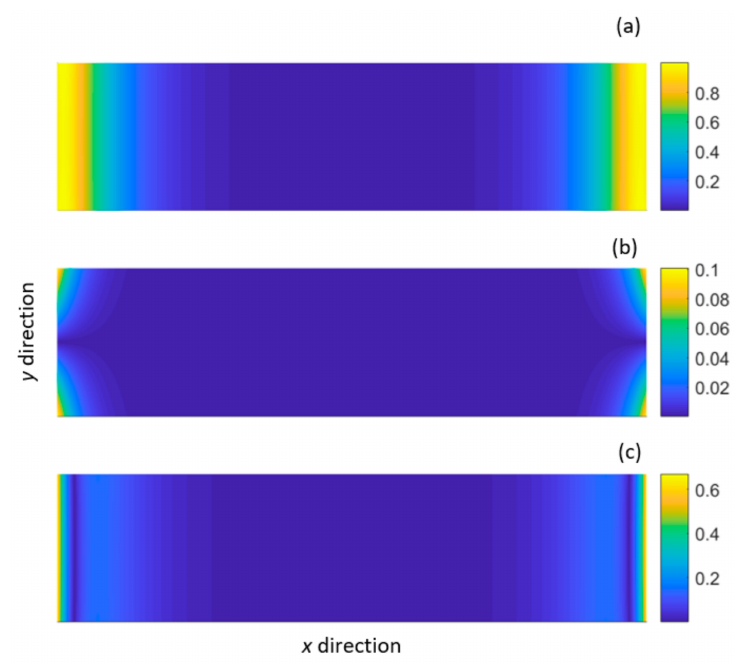
Figure 5. Normalised displacement distribution of the symmetric mode (S0*): ( a ) shear displacement